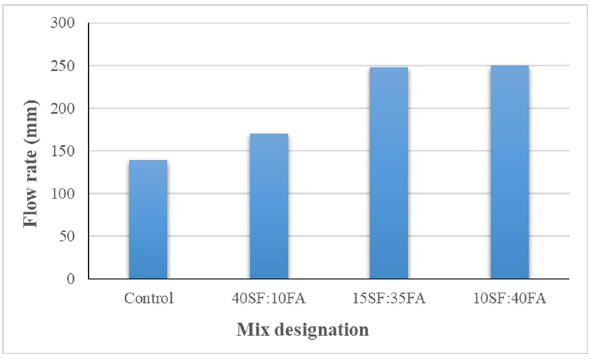
Figure 1: The fl ow rate results of